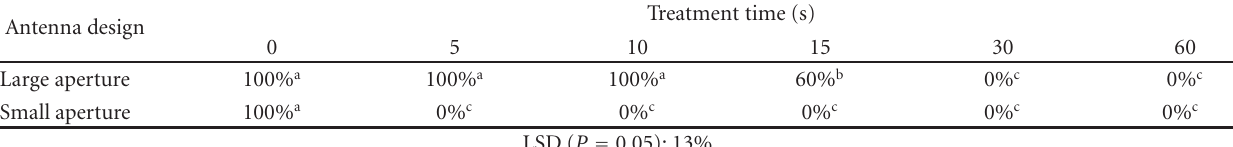
Figure 7: Paddy melon plants (a) immediately after microwave treatment for 15 seconds and (b) 11 days after treatment. Table 1: Mean percentage of una ff ected or recovered paddy melon plants according to treatment combination.